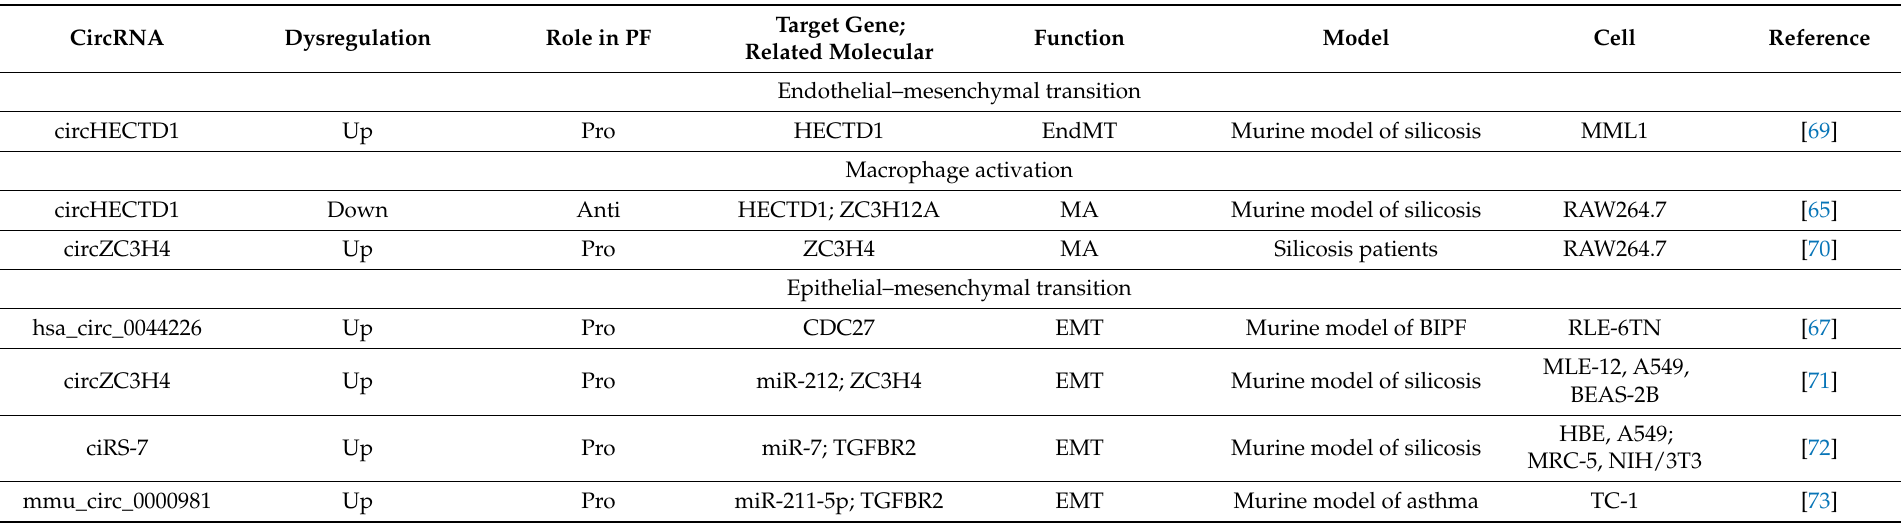
Table 2. Dysregulated circRNAs in pulmonary